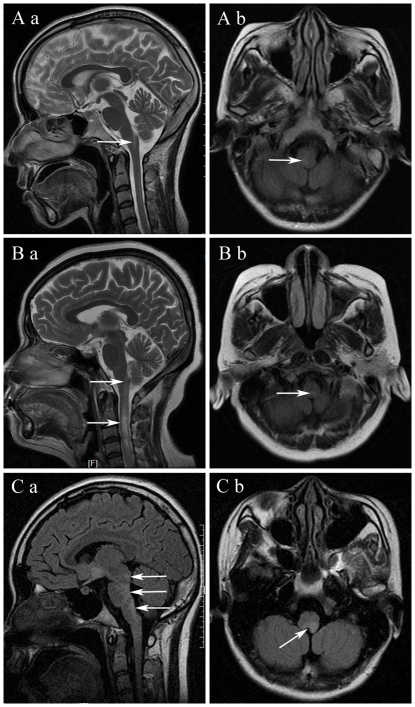
Brain stem lesions (arrows) on MRI of neuromyelitis optica (NMO).(A) MRI showing medulla lesion located in the dorsal part with poorly defined shape. (B) MRI showing linear medullospinal lesions. (C) MRI showing distribution of NMO-characteristic brain lesions (dorsal brain stem) corresponding to sites of high NMO-IgG expression.